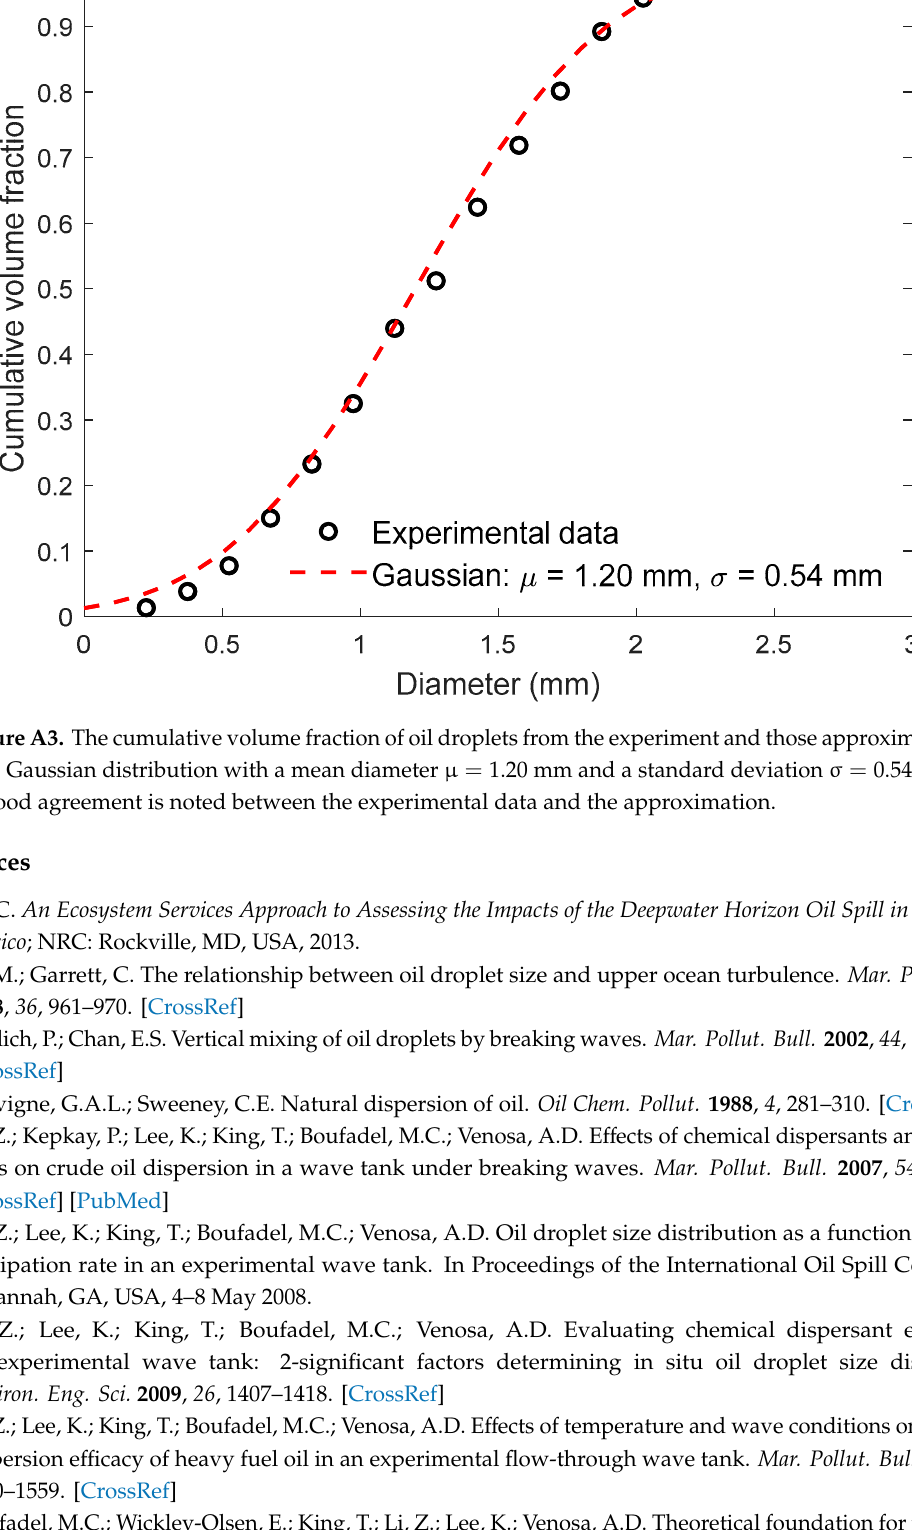
red line shows a realistic normal distribution, and the blue crosses indicate the experimental data.